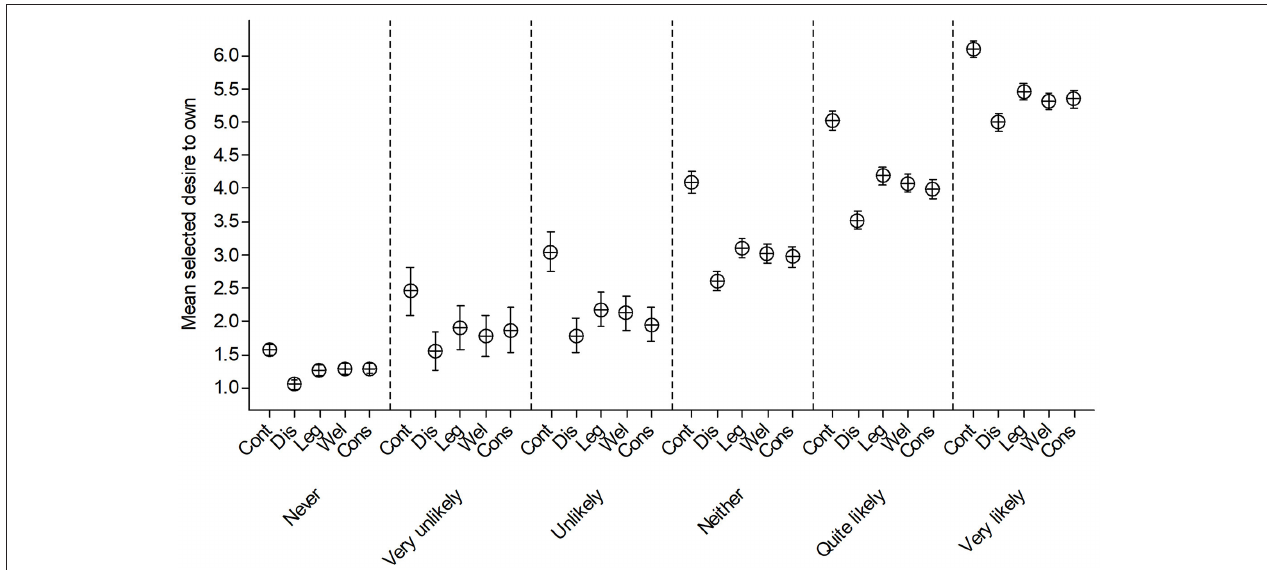
FIGURE 3 | Mean desire to own (on a 1–10 scale) across all taxa and respondents, showing how this, and responses to experimental treatments, varies with respondents’ previously stated likelihood of purchasing an exotic in the next 2 years.